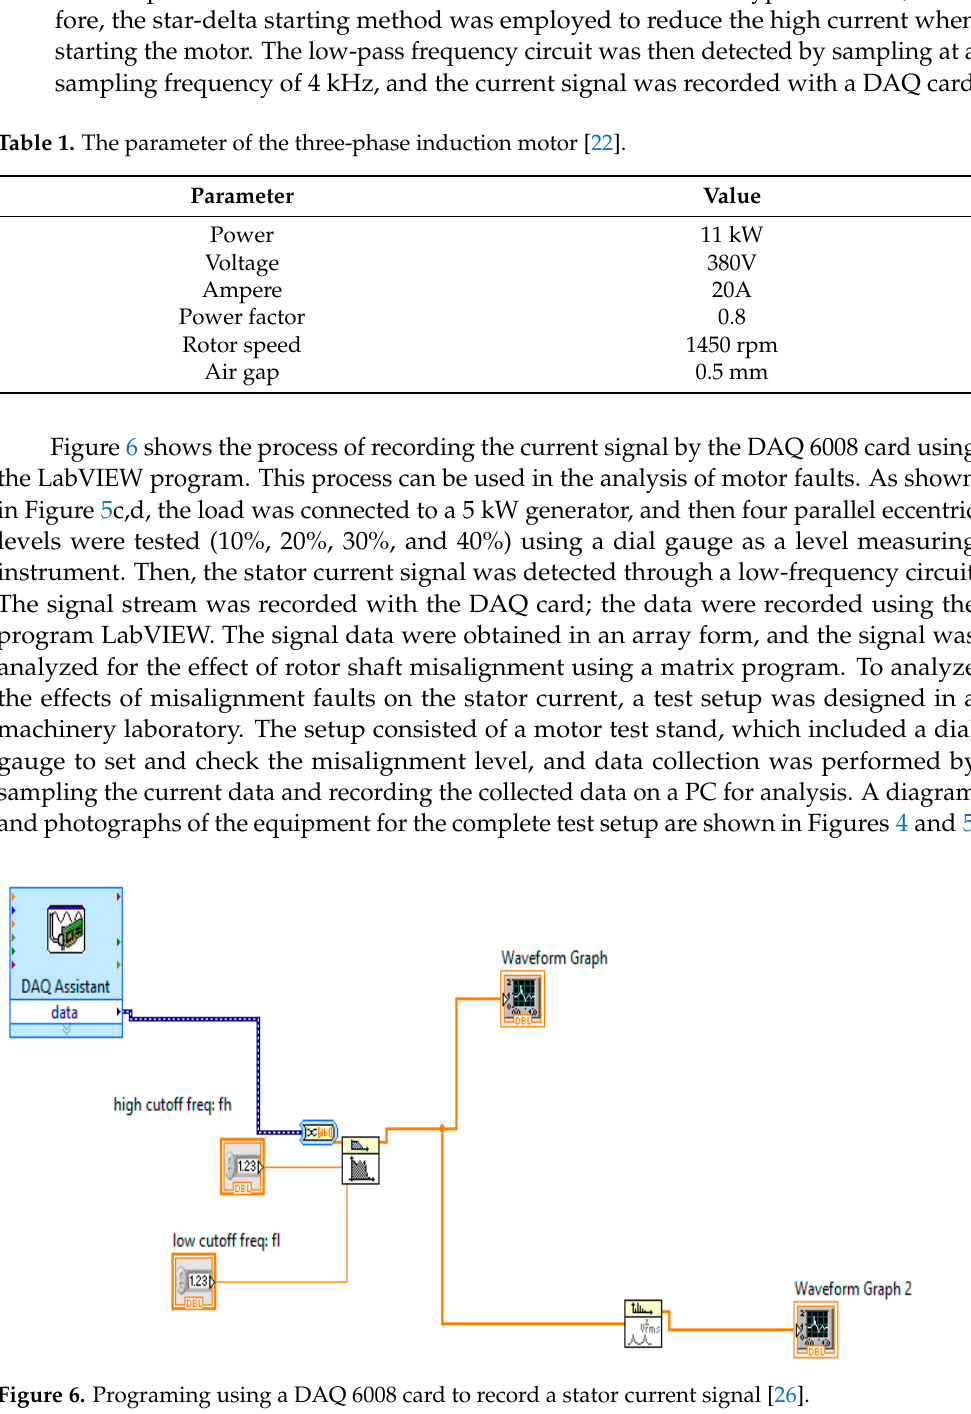
Figure 6. Programing using a DAQ 6008 card to record a stator current signal